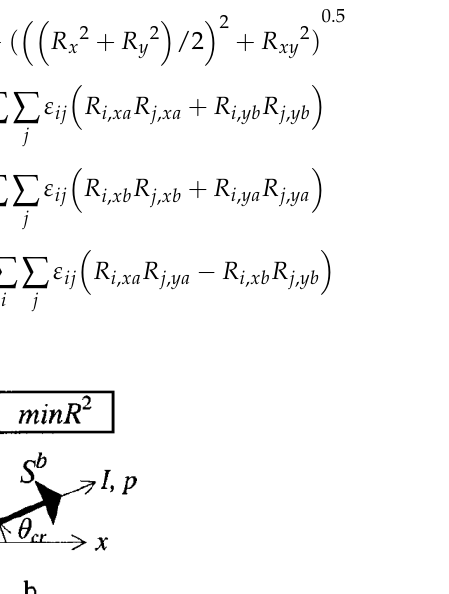
Figure 1. Reference system; ( a ) maximum reactions; ( b ) minimum reactions [22].